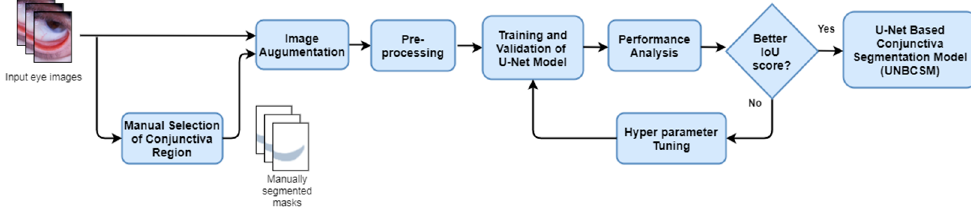
Figure 1. Flow graph of training the segmentation model.